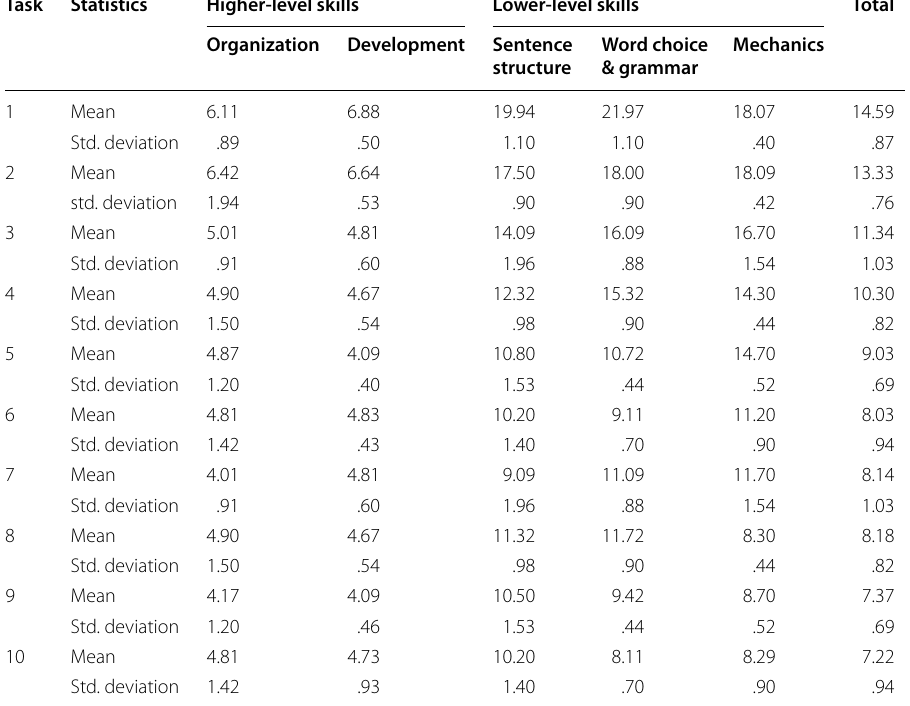
Table 4 Repeated measures ANOVA on higher-level and lower-level writing skills Component Sum of squares df Mean square F Sig Partial η 2 Organization Between group 210.333 Within group Development Between group Within